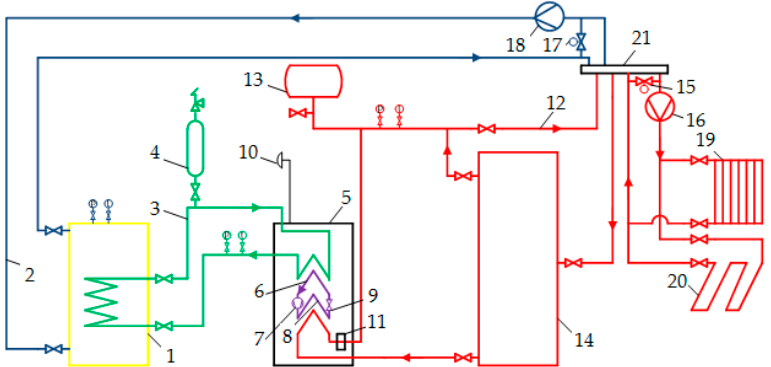
Figure 2. Scheme of a research heat pump plant. 1—cold water tank, 2—cold water loop, 3—pro-